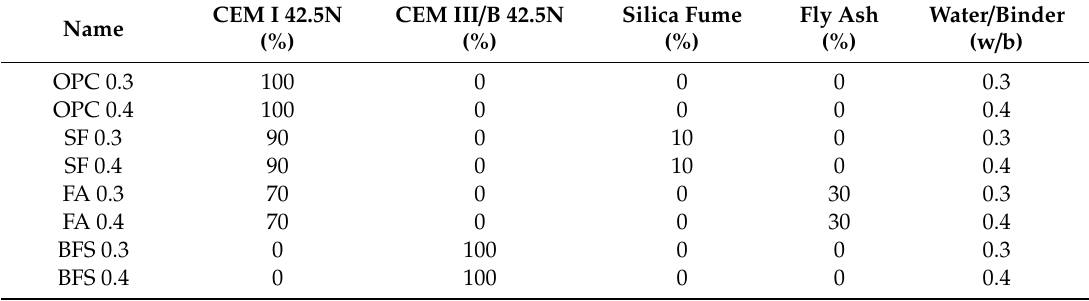
Table 3. Mixture composition of Portland cement paste and blended cement paste (% by weight).